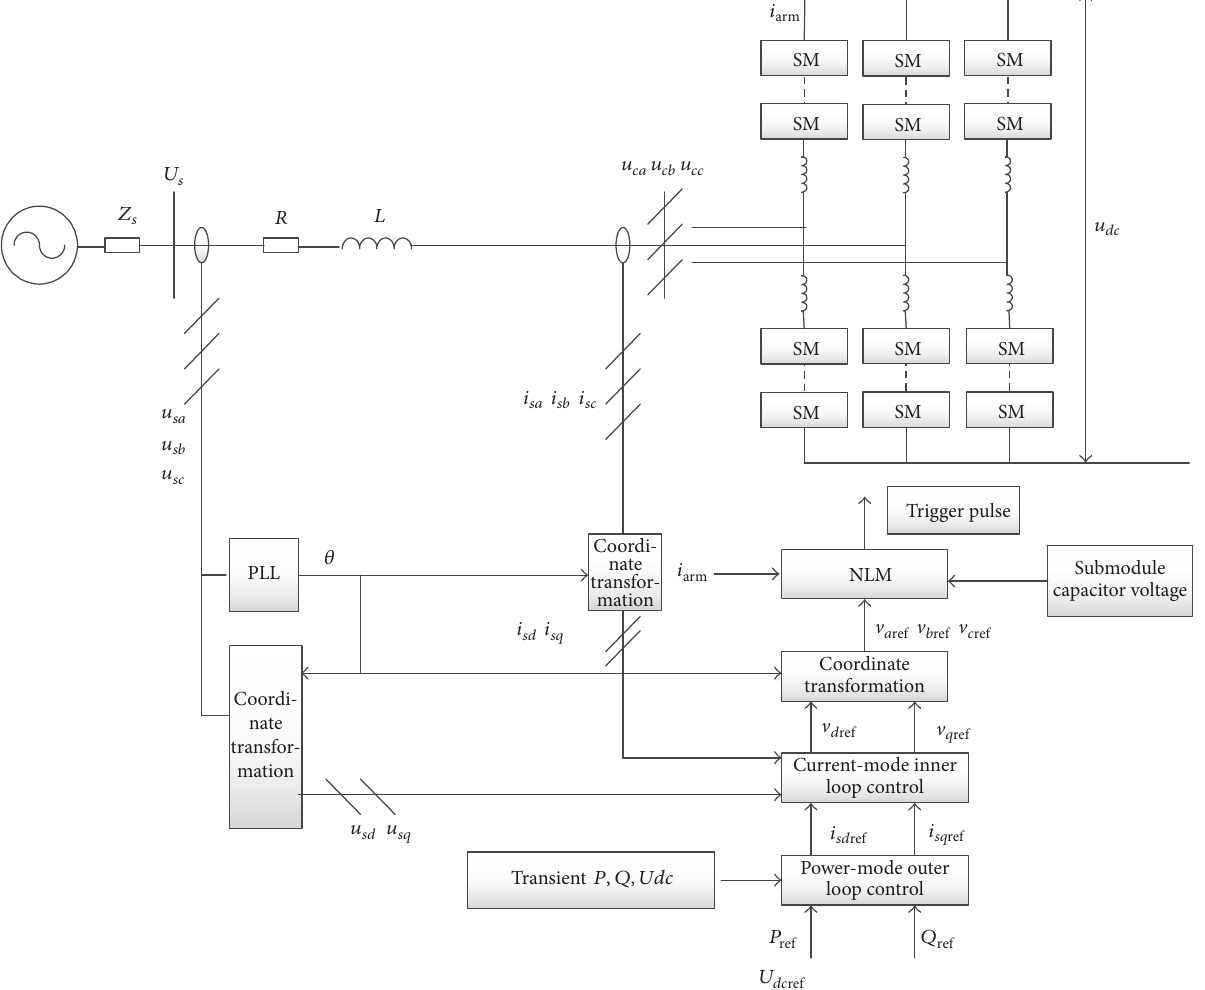
Figure 3: The schematic diagram of MMC control